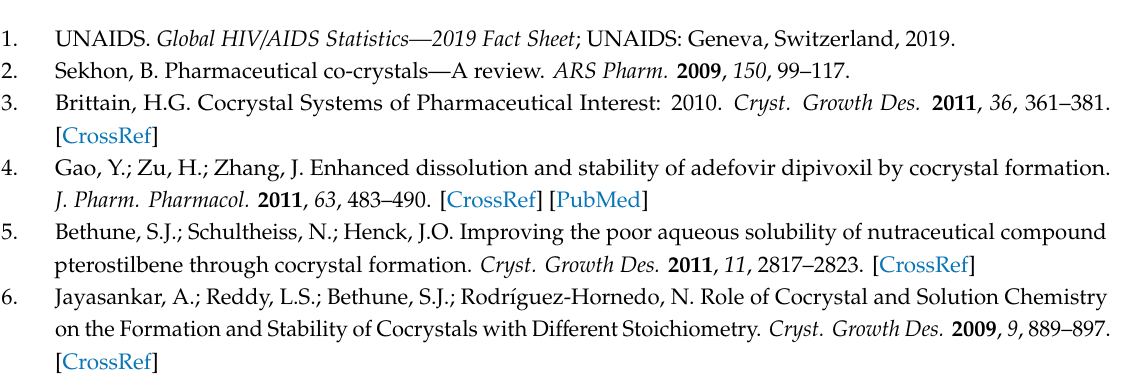
Table S1: Summary of melting temperatures of AZT, 3TC, reported co-crystal value and the OPT-NCC. Figure S1: DSC thermogram of 3TC (Black), AZT (Orange) and OPT-NCC (Blue). Table S2: Summary of the comparison FTIR for the reported co-crystal and the OPT-NCC. Figure S2: A plot of the values reported in Table S2 reflecting a one-to-one agreement between the FTIR wavenumbers reported in the literature [68] (blue) and those recorded for the NCC (orange). Figure S3: FTIR spectra of the OPT-NCC (orange), 3TC (blue) and AZT (black). Figure S4: PXRD di ff ractograms of OPT-NCC and Co-crystal (Di ff ractogram obtained from CSD [69]). Figure S5: TEM of uncoated bottom-up micro co-crystal. Figure S6: TEM depicting the mean particle size of the OPT-NCC, Figure S7: TEM images of the smallest product obtained (OPT-NCC). Figure S8: DLS intensity size distribution curve of the